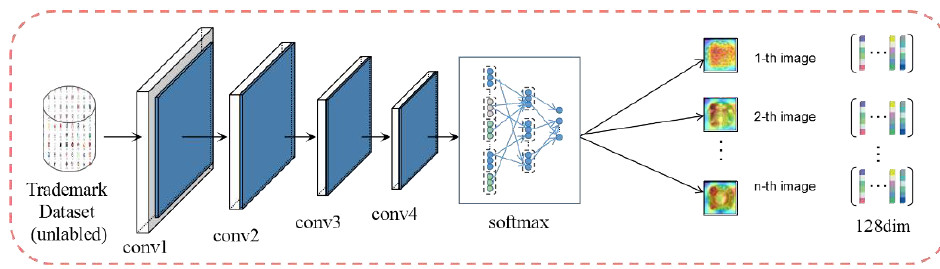
Figure 4. Unsupervised feature leaning approach.